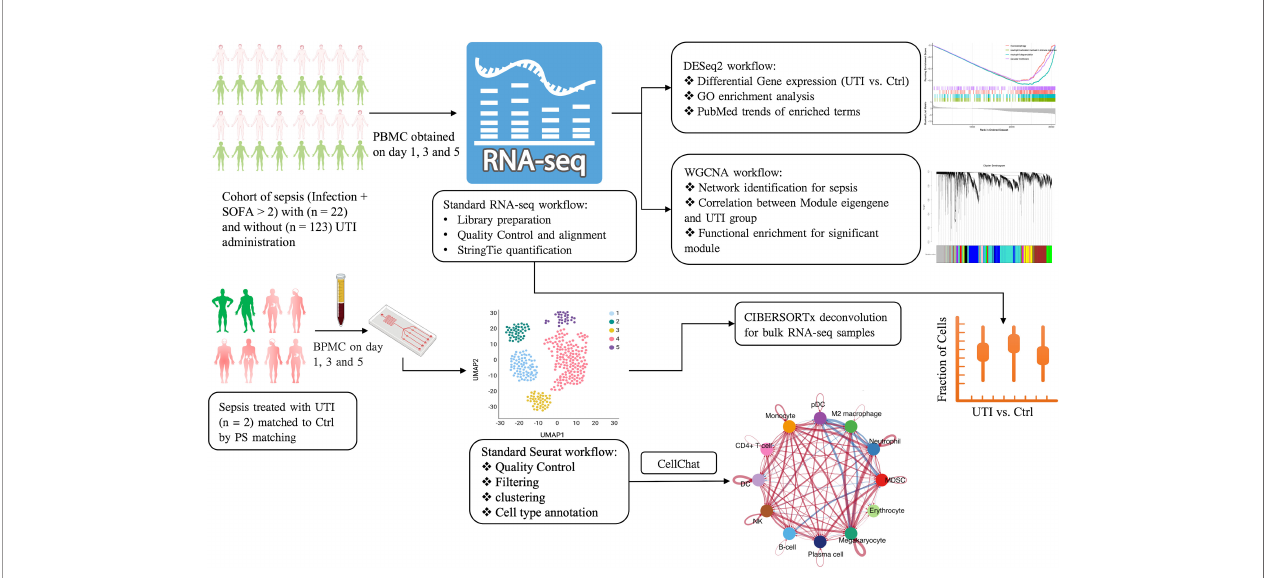
FIGURE 1 | Schematic illustration of the integrated analysis of bulk and single cell RNA-seq analysis. PBMC, peripheral blood mononuclear cells; UTI, ulinastatin; SOFA, sequential organ failure assessment; GO, gene ontology; PS, propensity score; MDSC, Myeloid-derived suppressor cells; WGCNA, Weighted correlation network analysis; UMAP, Uniform manifold approximation and projection; pDC, Plasmacytoid dendritic cells; DC, dendritic cells; NK, natural